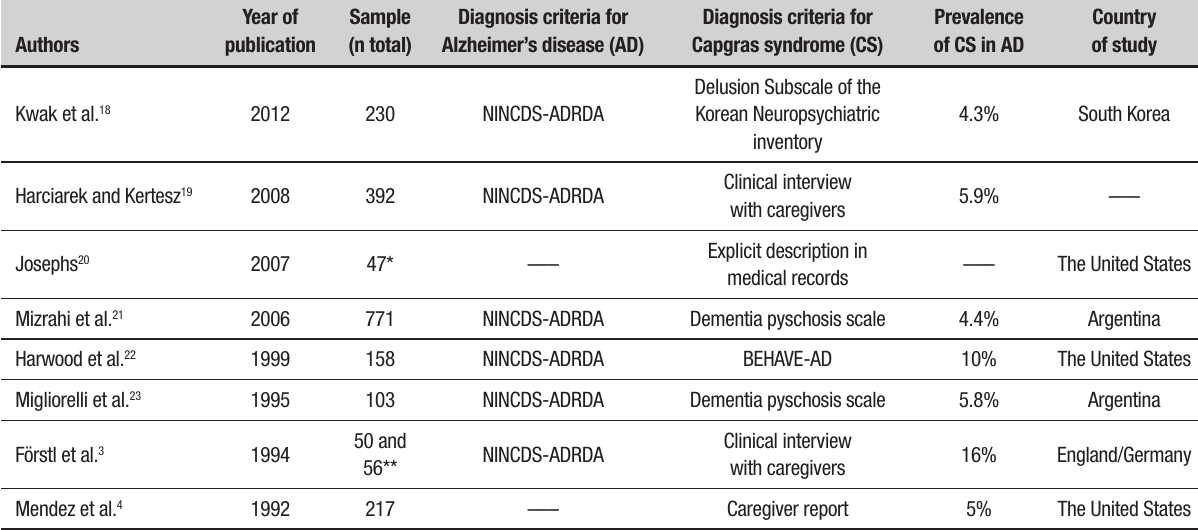
Table 1. Characteristics of studies included in the